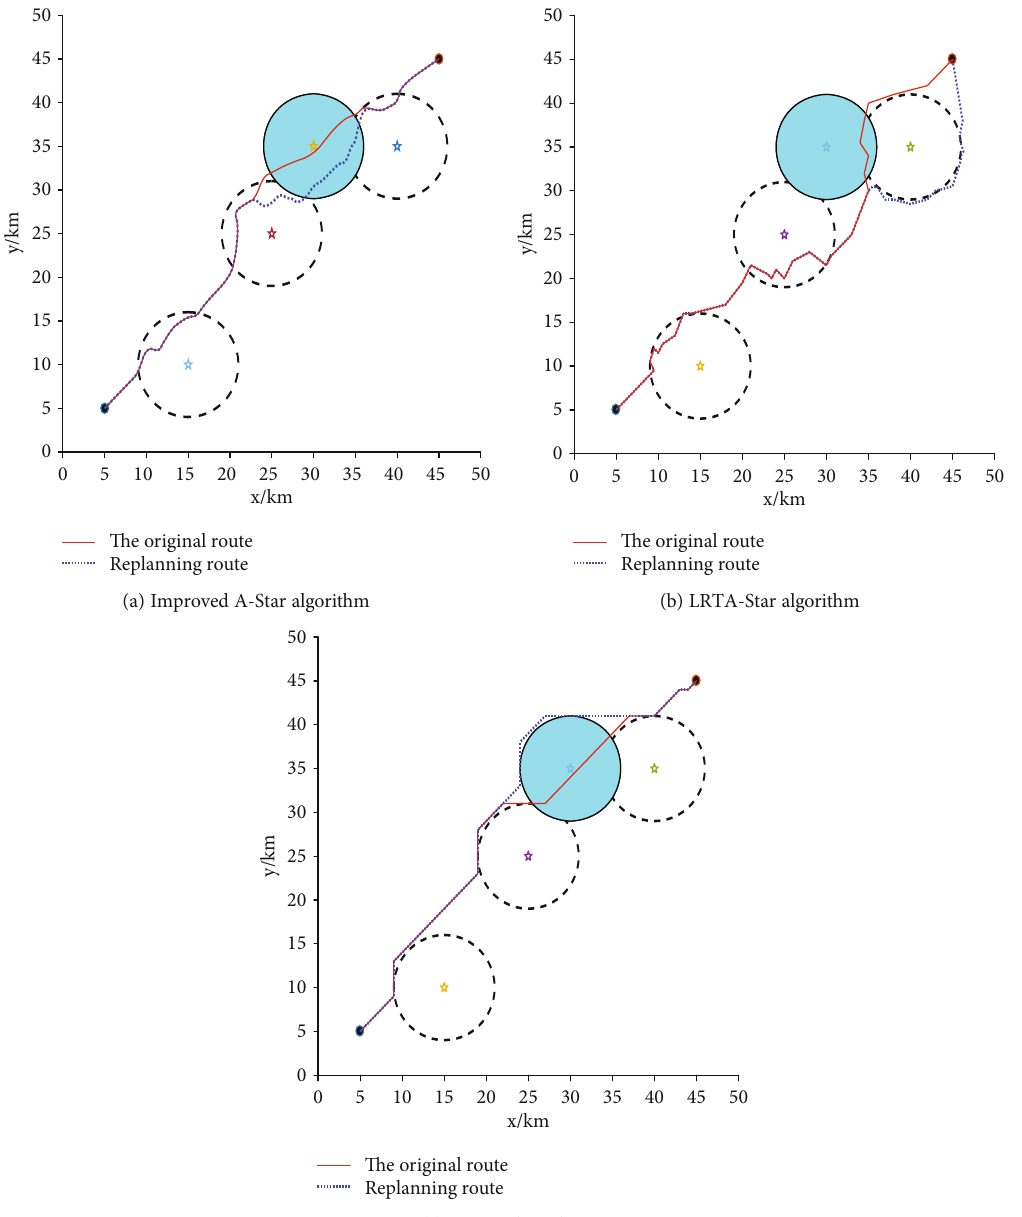
Figure 5: Numerical results of penetration path planning in the fi rst